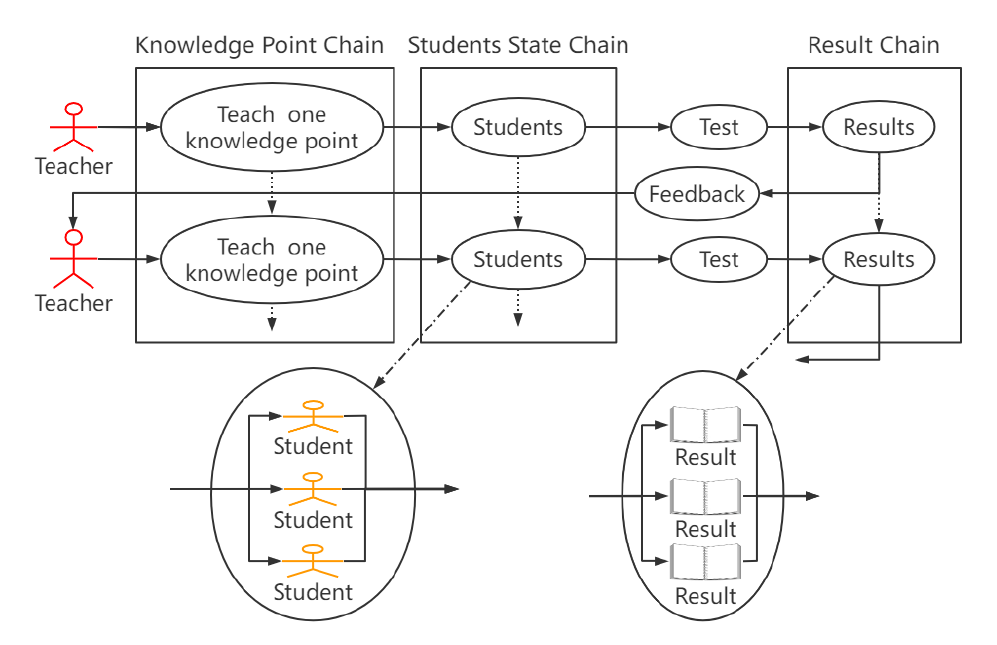
Figure 2. (I) The teacher teaches a knowledge point; (II) The students study it with the changes in their student states; (III) The results of in-class and off-class tests for students are observed. During the continuous teaching process, a knowledge point chain, a student state chain, and a student test result chain are